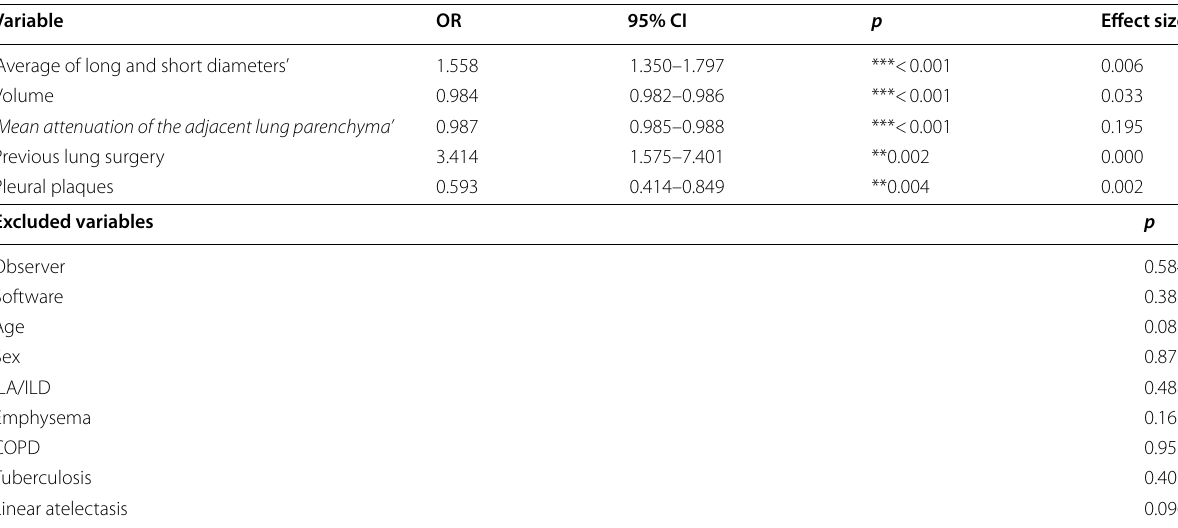
Table 4 Parameter estimates for the prediction of nodule segmentation success and adequacy